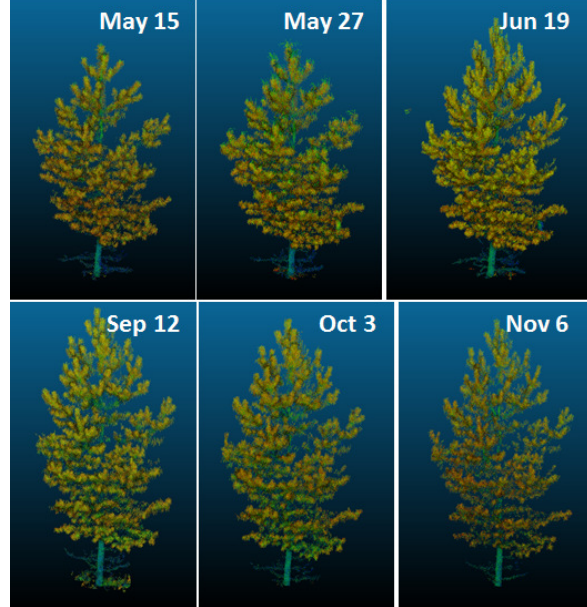
Figure 2. HSL time series (growing season 2013) of NDVI plotted over the HSL point cloud shows the new growth in spring as well as dying and falloff of the old parts.